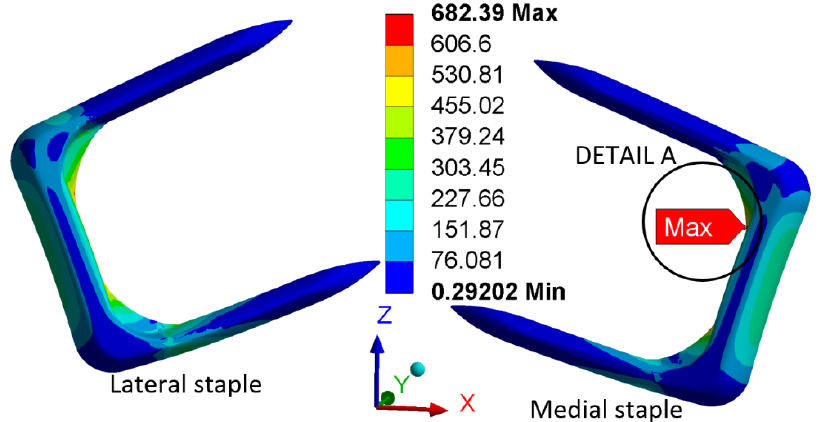
Figure 13. The distribution of the equivalent stress (von Mises) in the staples (MPa).